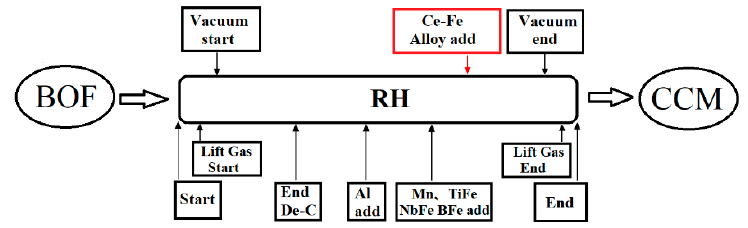
Figure 1. Ce ‐ Fe alloy added during steelmaking processes. Figure 1. Ce-Fe alloy added during steelmaking